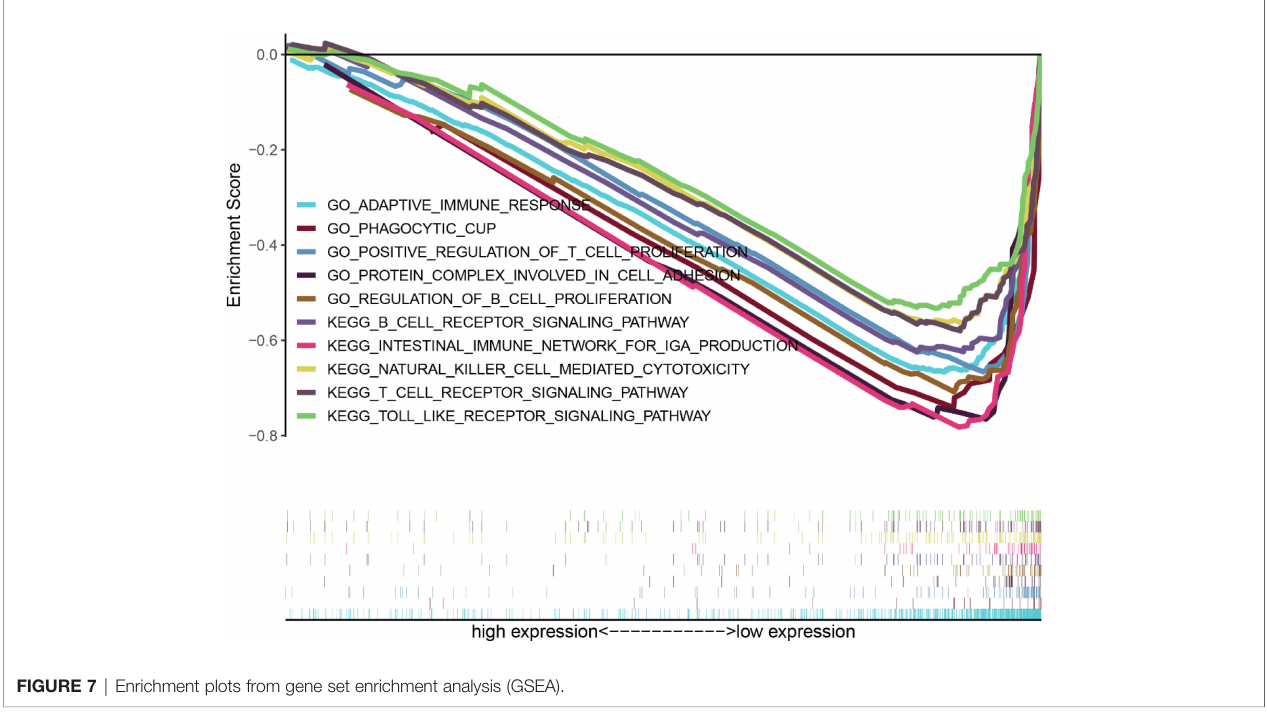
FIGURE 7 | Enrichment plots from gene set enrichment analysis (GSEA).